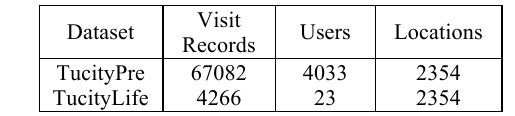
Table 1. Statistics of users, locations, and visit records of the used datasets